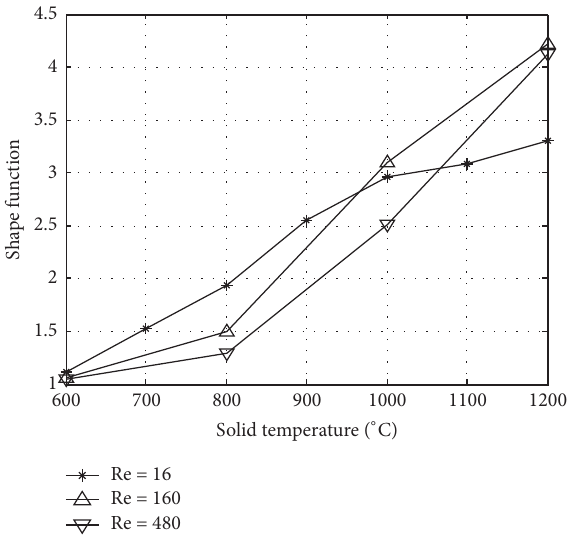
Figure 10: Shape function with different